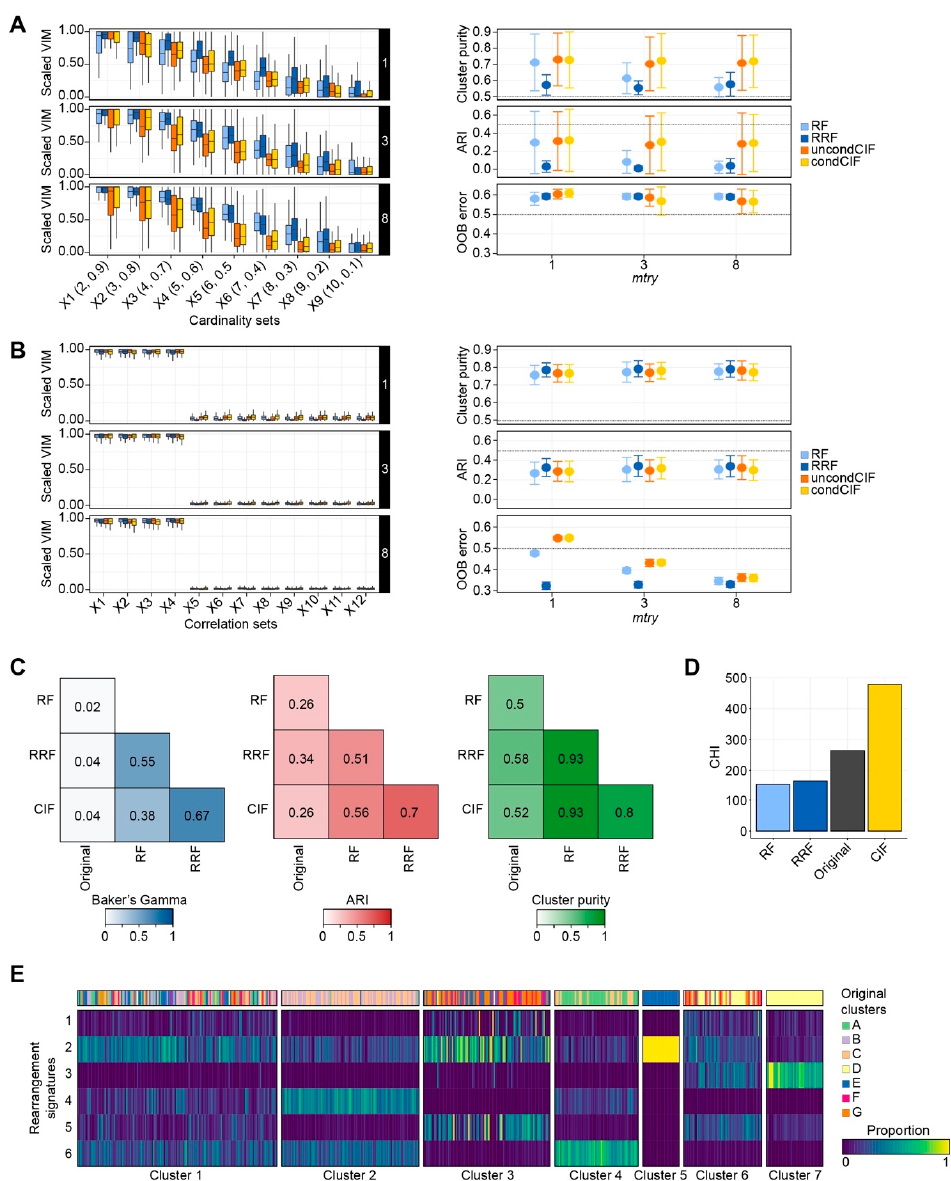
Figure 1. Performance of permutation-based random forest classification. ( A ) (left) Boxplot depicting scaled variable importance measures (VIMs) (y-axis) for random forest (RF) (light blue), regularised random forest (RRF) (dark blue), unconditional conditional inference forest (uncondCIF) (orange) and conditional CIF (condCIF) (yellow) in different cardinality simulation studies (x-axis). Performance of each permutation-based RF method was assessed by varying the number of features available for a split point ( mtry of 1, 3 and 8). (right) Cluster purity, ARI (Adjusted Rand Index) and out-of-box (OOB) error for the various RF methods. The error bars depict the distribution of each measure. ( B ) As Figure A, but for the correlation simulation studies. ( C ) The permutation-based random forest classifications (RF, RRF and CIF) were applied to six rearrangement signatures across 560 breast cancers and compared with the original clusters [3]. Level plots for Baker’s Gamma (blue), ARI (red) and Cluster purity (green) were used to compare the different classifications. ( D ) Barplot of the CHI measures (y-axis), representing the overall quality, defined as tightly packed and well-separated clusters given numerical data input, for each of the classifications (x-axis). ( E ) Heatmap of rearrangement signatures using permutation-based CIF. Rows are ordered by the tree derived from the consensus clustering on the CIF obtained forest distance. Seven clusters were found, each annotated with respect to the original clustering